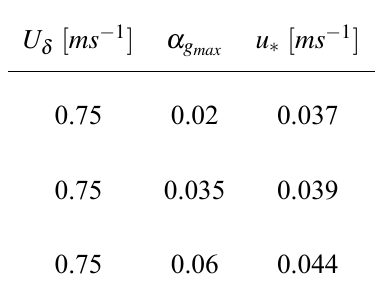
Reference parameters from experiments.